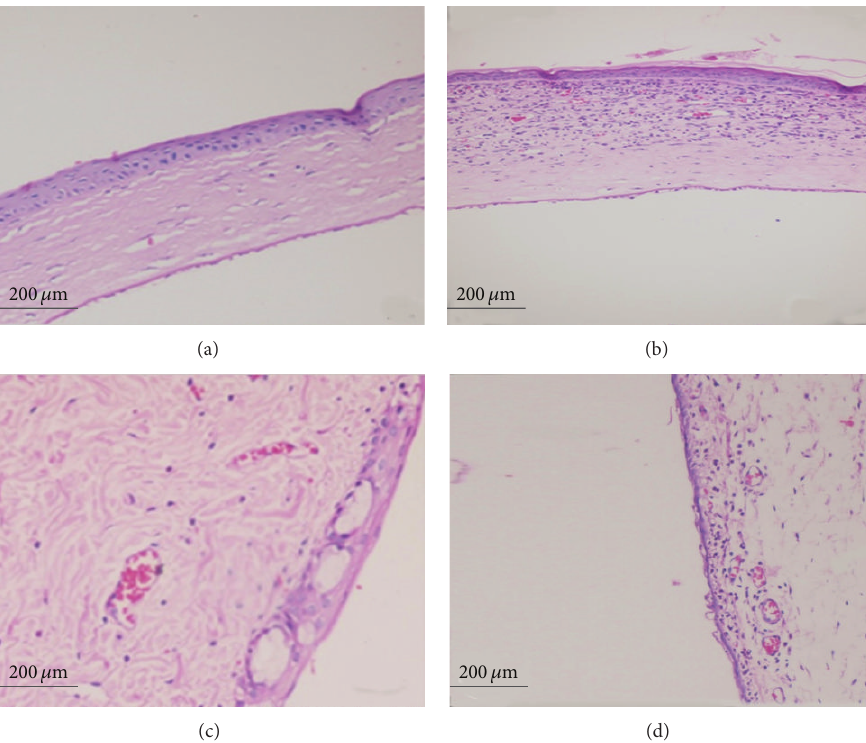
Figure 3: Light microscopy findings. Decreased corneal inflammation was observed in MSCs-treated rat cornea after one week of therapy (a) while diffuse leukocyte infiltration was observed in PBS-treated rat cornea (b). Resolved conjunctival inflammation was observed in MSCs- treated rat conjunctiva after one week of therapy (c) while diffuse leukocyte infiltration and vascular congestion were observed in PBS-treated rat’s conjunctiva (d). (H&E staining, magnification: ×